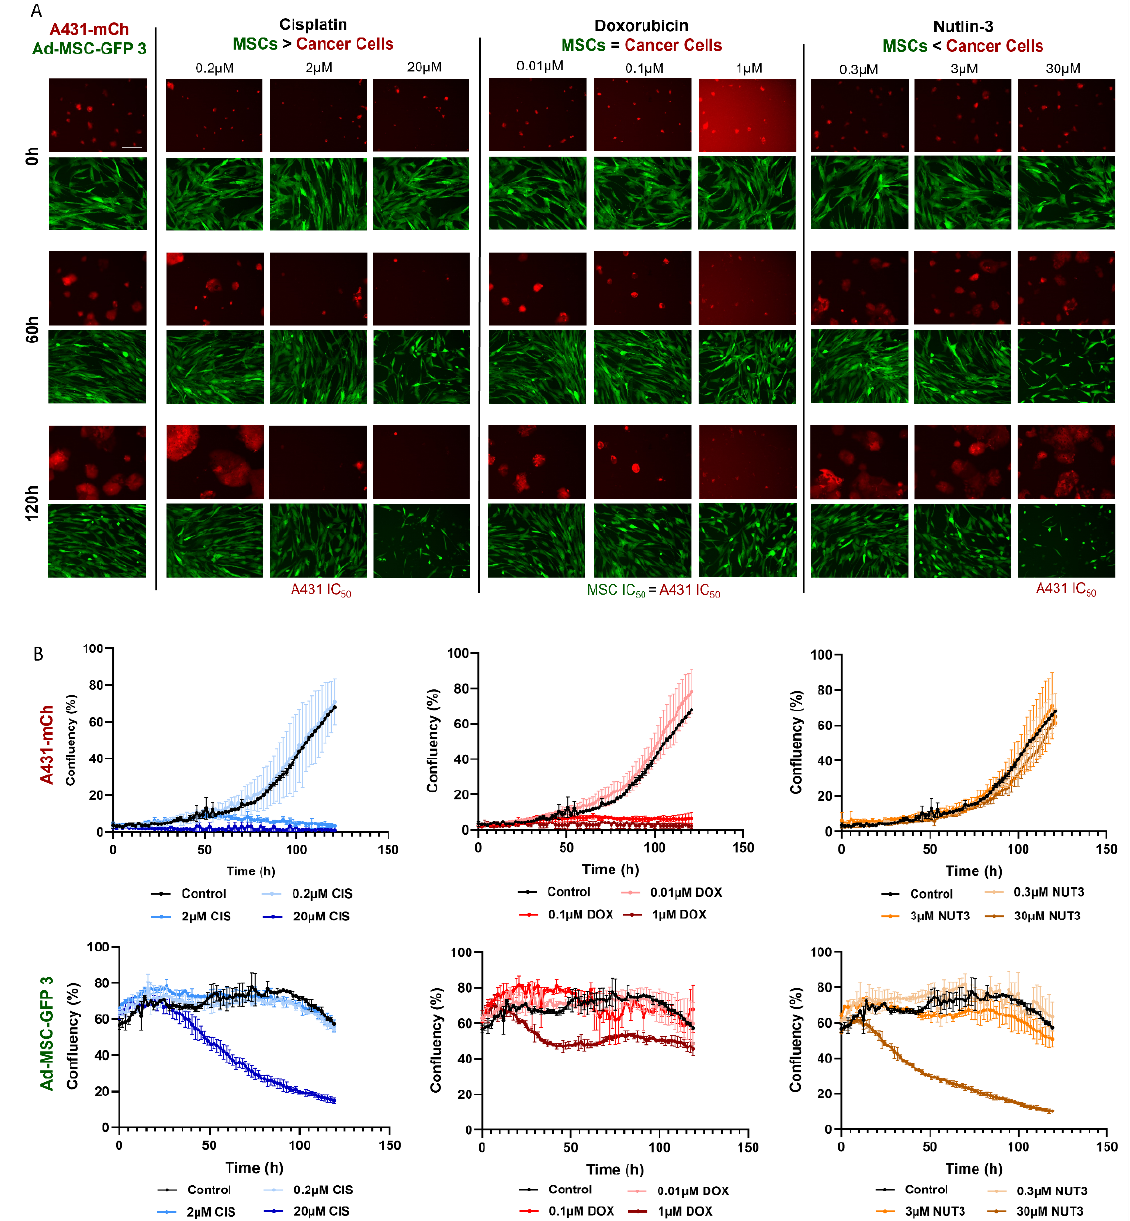
Figure 2. Live cell images of Ad-MSC-GFP 3 and A431-mCh cells after 120 h of treatment with cisplatin, doxorubicin, or nutlin-3. ( A ) Images were taken every 105 min for 120 h, and representative images were selected at 0, 60, and 120 h to show the progress of cultures under treatment with the indicated drugs and concentrations. Note that at 1 µ M of doxorubicin background fluorescence significantly increased due to the drug’s autofluorescence. ( B ) The changes in confluency (%) were calculated from 3 independent experiments using image analysis. Due to the larger size of the MSCs, confluency of MSCs is higher than that of cancer cell cultures from the start of the experiment. Upper row left from right: A431-mCherry cells treated with different concentrations of cisplatin, doxorubicin, or nutlin-3. Bottom row left from right: Ad-MSC-GFP 3 cells treated with different concentrations of cisplatin, doxorubicin, or nutlin-3.